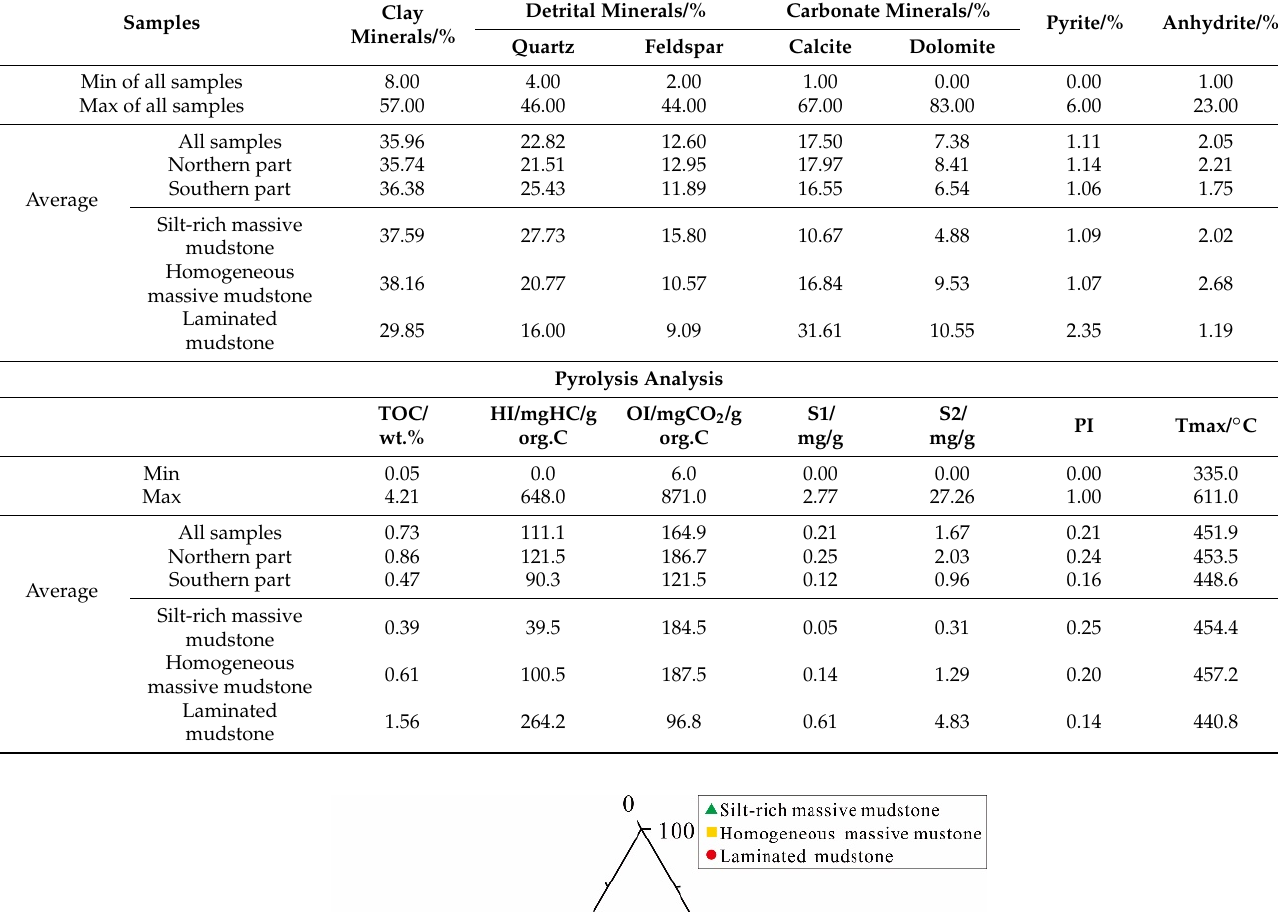
Table 1. Mineralogical composition and pyrolysis results of the mudrocks of Dongpu Sag. XRD test.